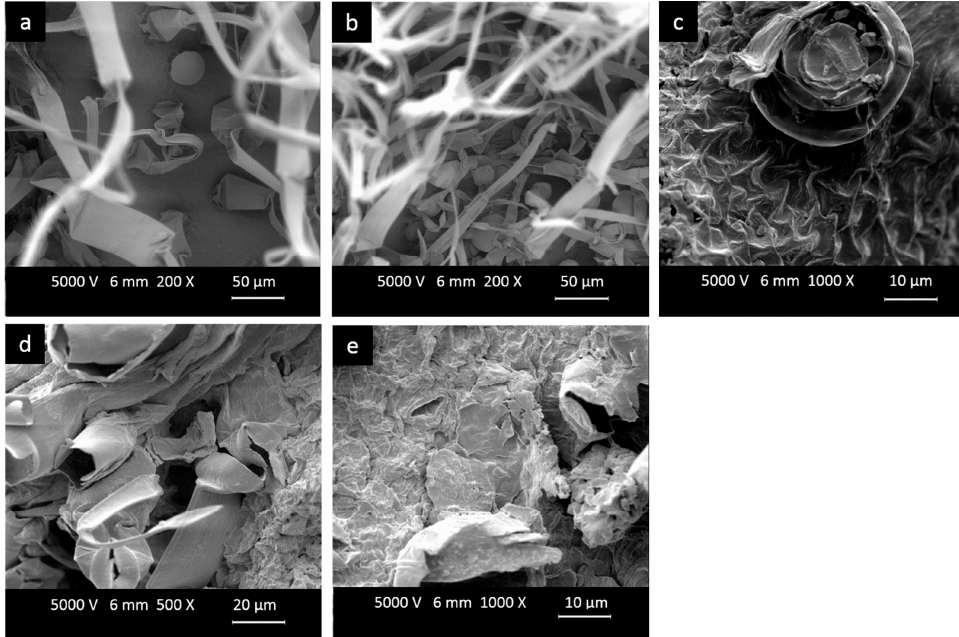
Figure 1. Scanned electron micrograph of young yacon leaves of the red cultivar ( a ) upper surface of fresh leaves-200×; ( b ) lower surface of fresh leaves-200×; ( c ) surface of dried leaves-1000×; ( d ) surface of dried leaves after OH-DE-500× and ( e ) surface of dried leaves after DE-1000×. Figure 1a,b show the glandular and non-glandular trichomes on the upper and lower surface of epidermis of a fresh leaf, respectively. Non-glandular trichomes are in the form of hairs and glandular trichomes are raised above the epidermis of the leaves. The glandular trichomes take part in the production and storage of compounds that are essential for plant adaptation and interaction with